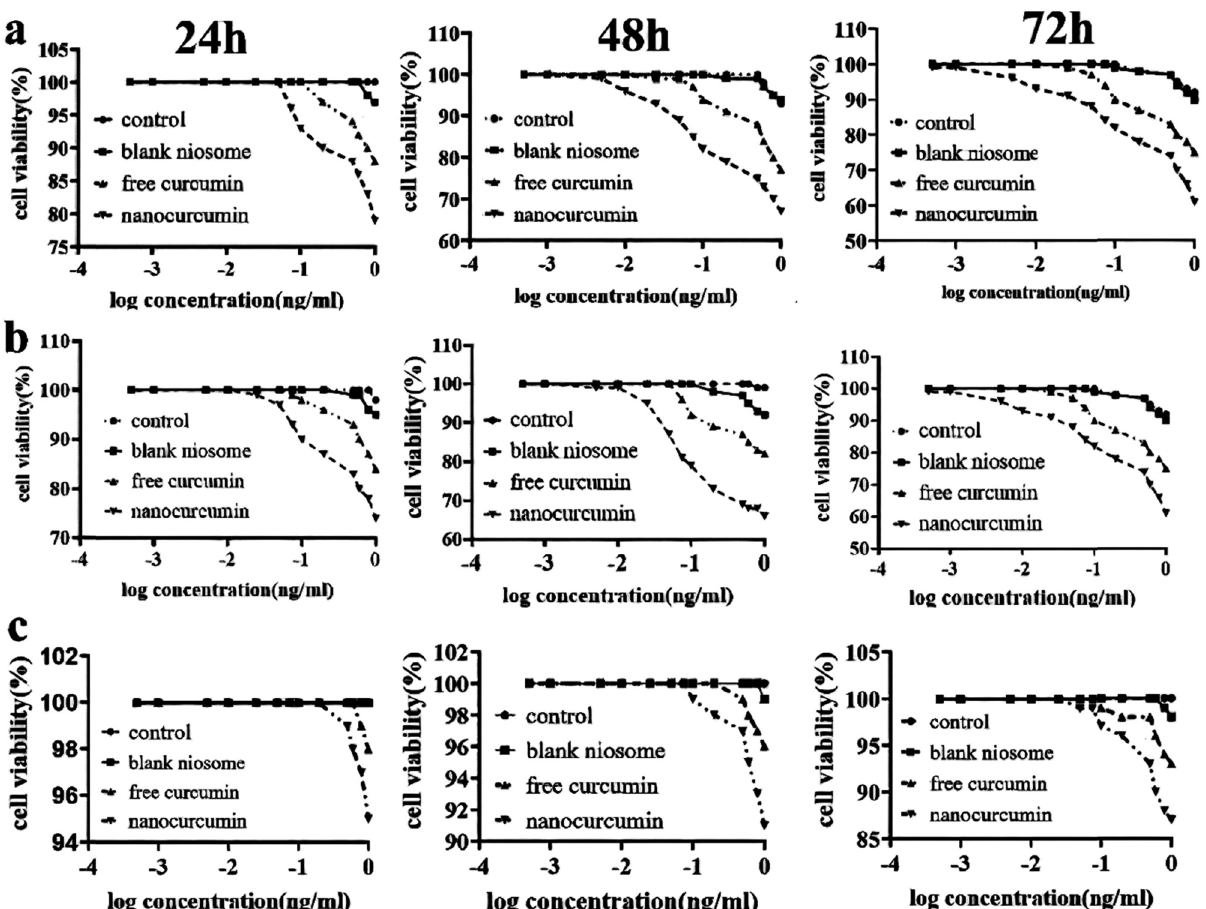
Figure 6: ( a ) The cell viability 2,5 - diphenyl - 2H - tetrazolium bromide ( MTT ) analysis of the modi fi ed niosomal NPs in A270CP - 1, ( b ) MTT analysis of the modi fi ed niosomal NPs in A270S cells, and ( c ) MTT analysis of the modi fi ed niosomal NPs in MCF10 - A cells. The assays were carried out three times to obtain the mean ± standard